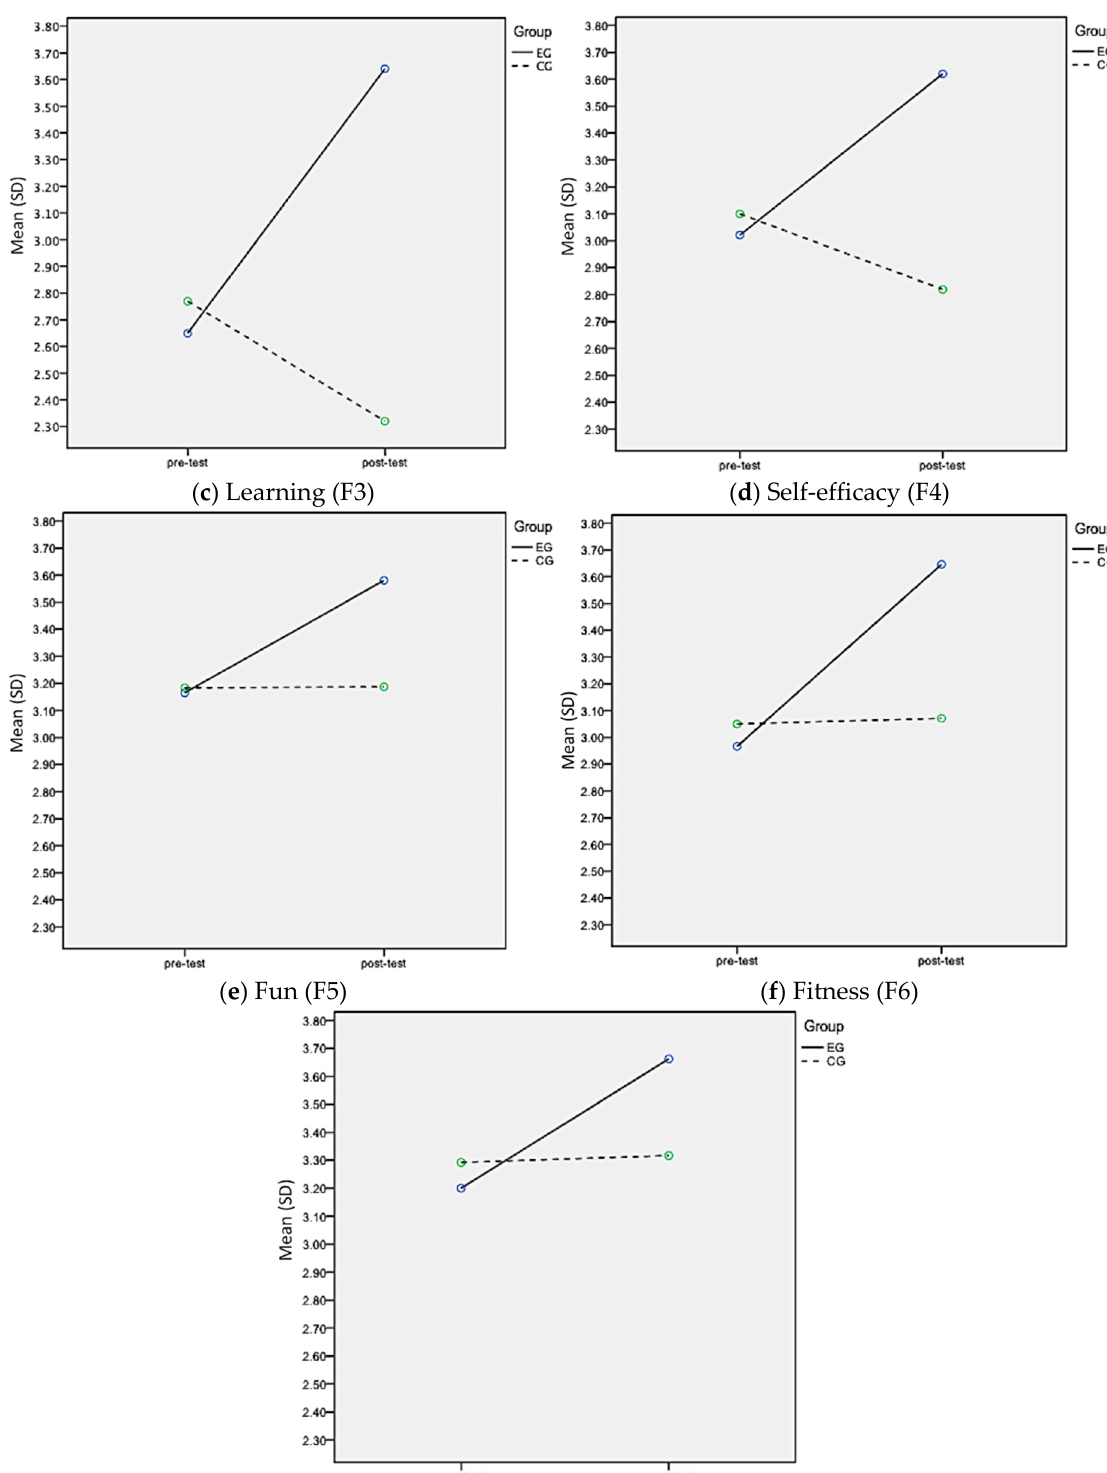
Figure 1. Scale Mean Values of the Experimental and the Control Groups at Pre-test and Post-test.